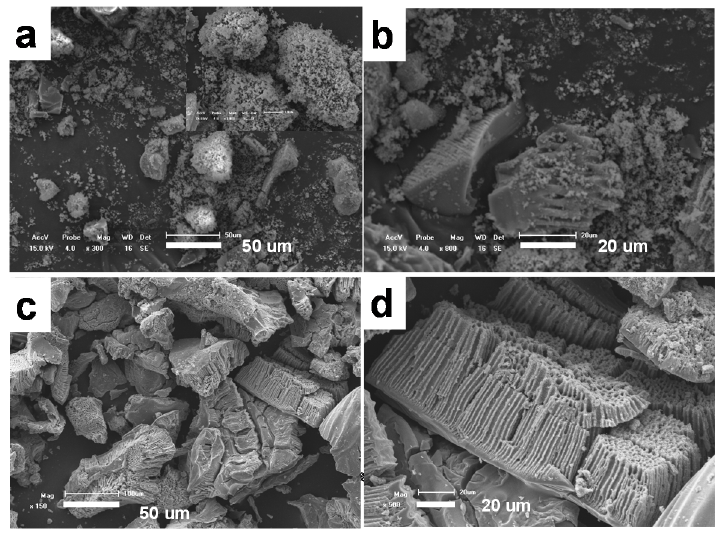
Figure 1. SEM images of titanium precursor prepared ( a , b ) without the addition of citric acid, ( c , d ) with 0.32 g citric acid.